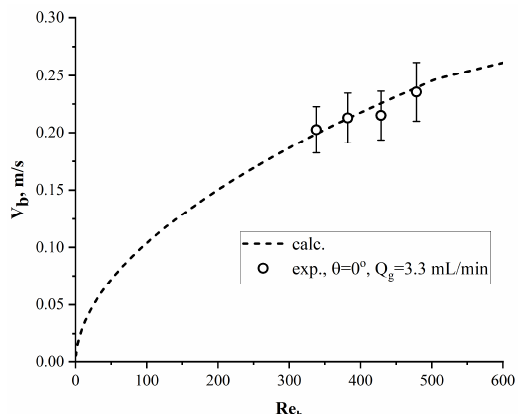
Figure 3. Comparisons of bubble rise velocity in vertical pipe ( θ = 0 ◦ ) in experiments, and calculated bubble rise velocity.